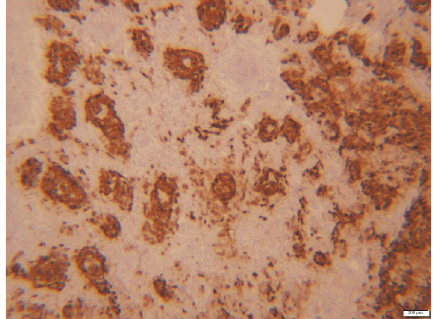
Figure 2: Immunohistochemistry of the tumor cells which were positive for